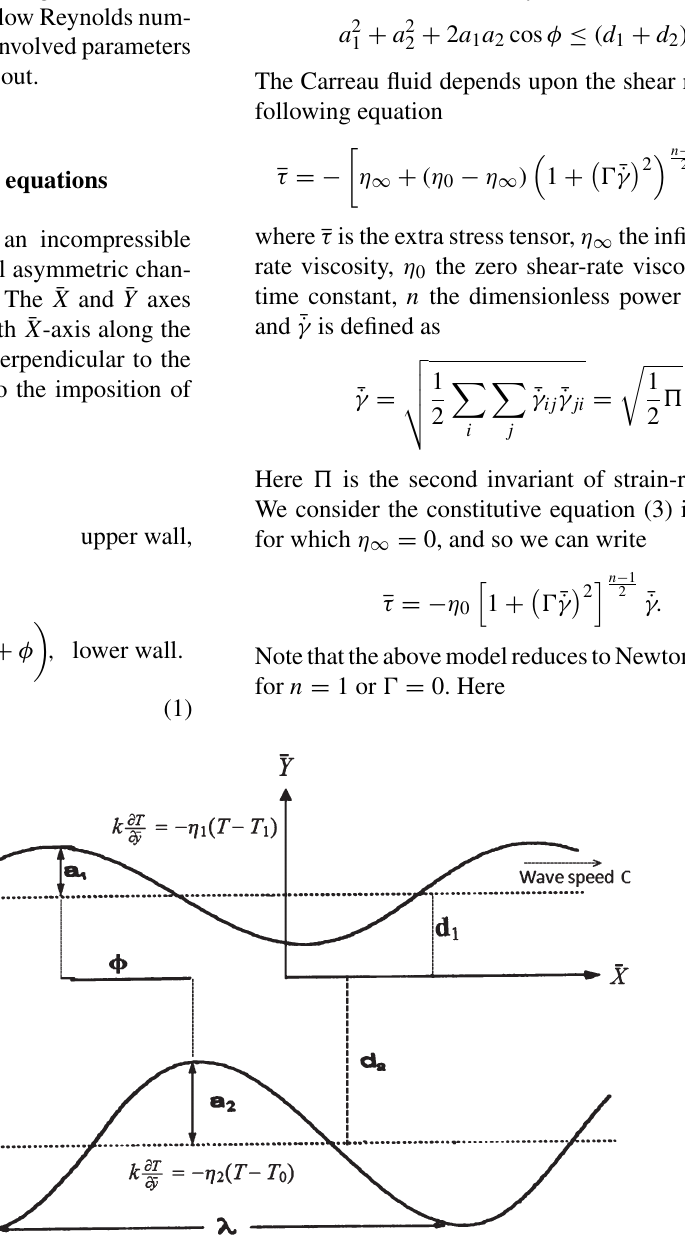
Fig. 1. Geometry of the